Question: Which visualization type does this figure use?
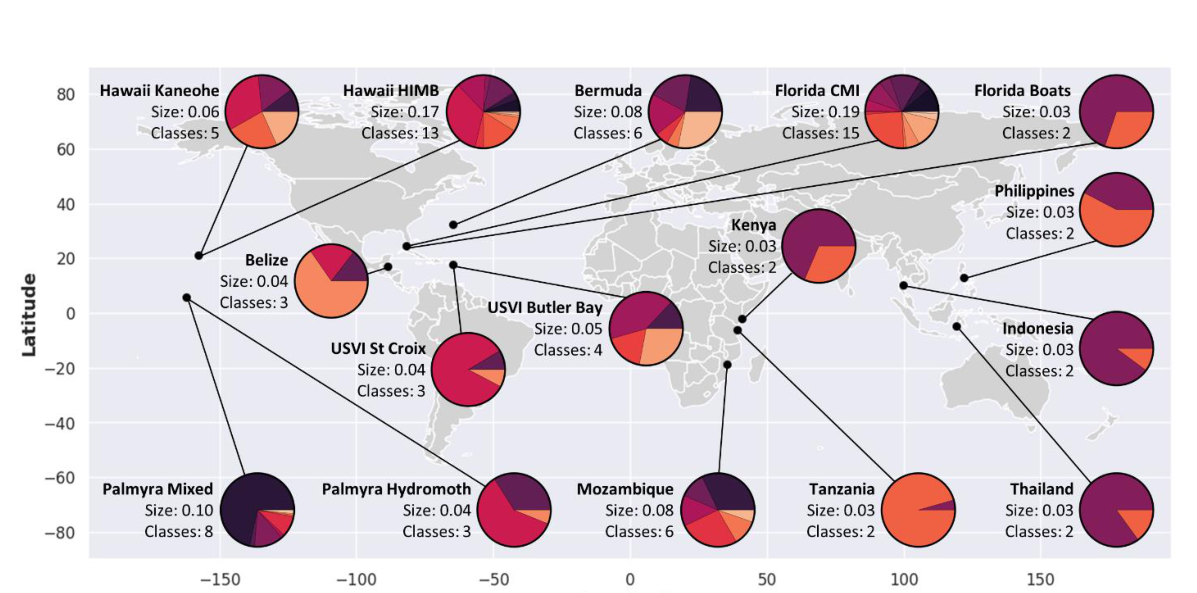
Answer: pie